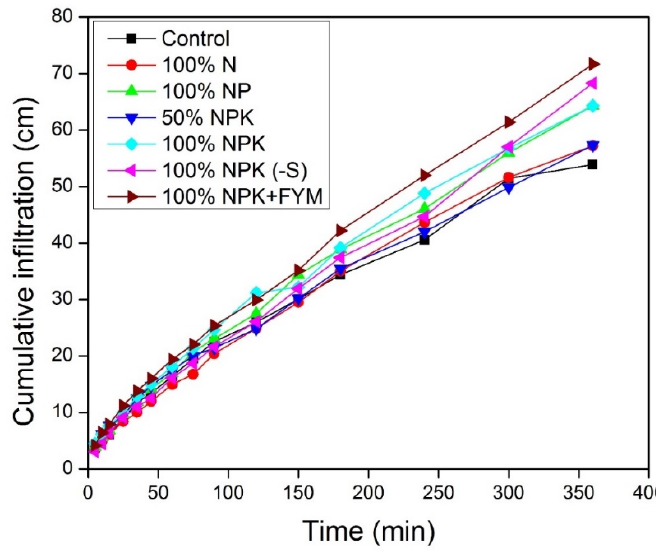
Figure 1. Cumulative infiltration against time under different fertilizer treatments. The differences in cumulative infiltration means at 360 min were statistically significant at P ≤